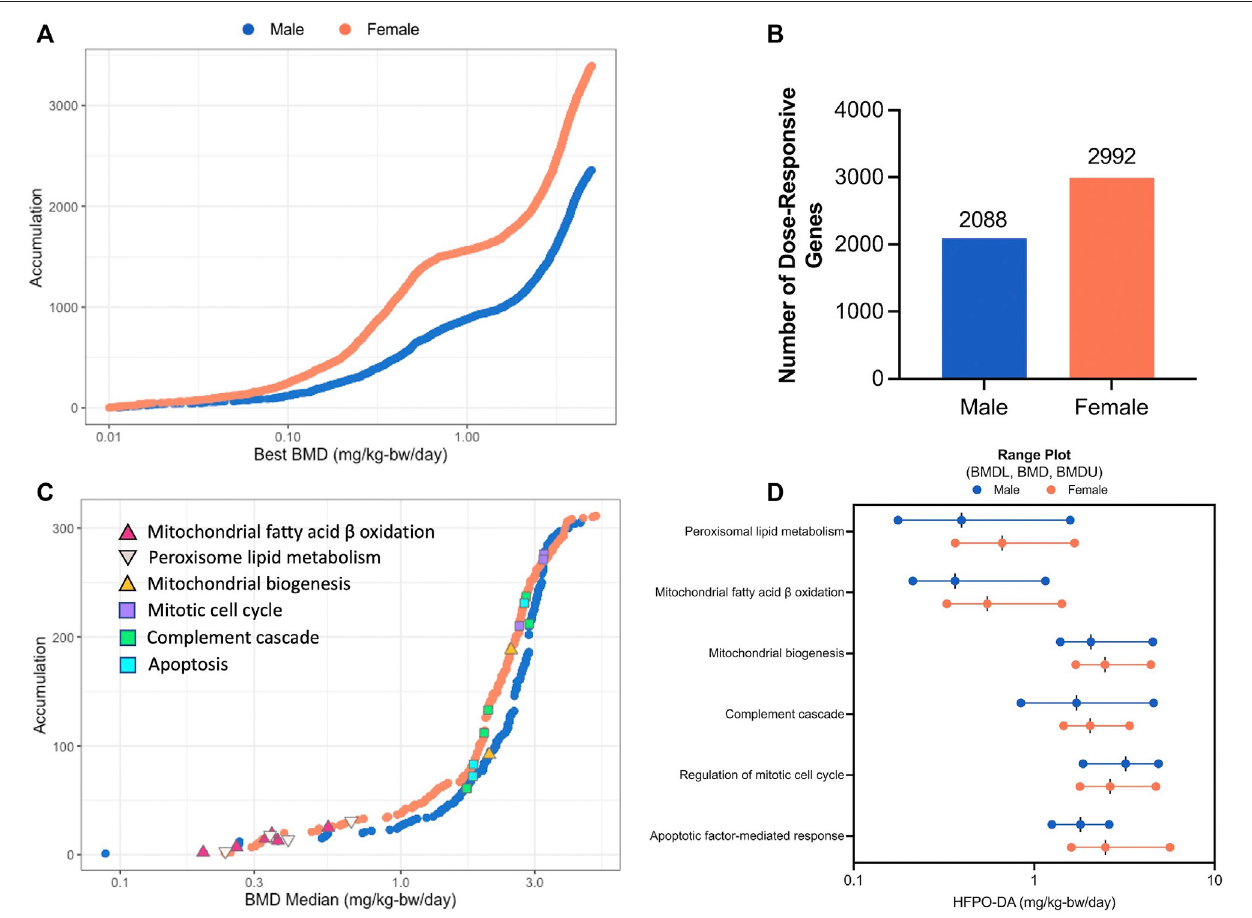
FIGURE3 | BMD analysisvisualizations (A) Accumulationplots ofmodeled benchmark doses among signi fi cantdose-responsive probes inmale and female mice (best fi t p -value ≥ 0.1) (B) Number of signi fi cant dose-responsive genes by sex (best fi t p -value ≥ 0.1) (C) Accumulation plots for signi fi cantly enriched pathways in male and femalemice (Fisher ’ sExactTwo-Tail < 0.1)withselectedgenesetsannotatedbycolor-codedtriangles andsquaresasindicatedintheinsetlegend (D) Rangeplots (median BMDL, median BMD, median BMDU) for the same selected gene sets depicted by triangles and squares in fi gure panel (C)